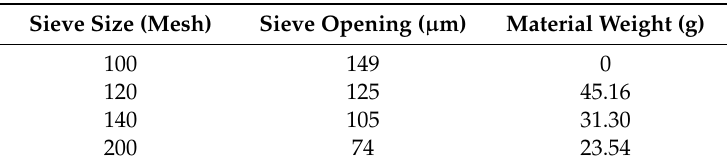
Table 1. Proppant